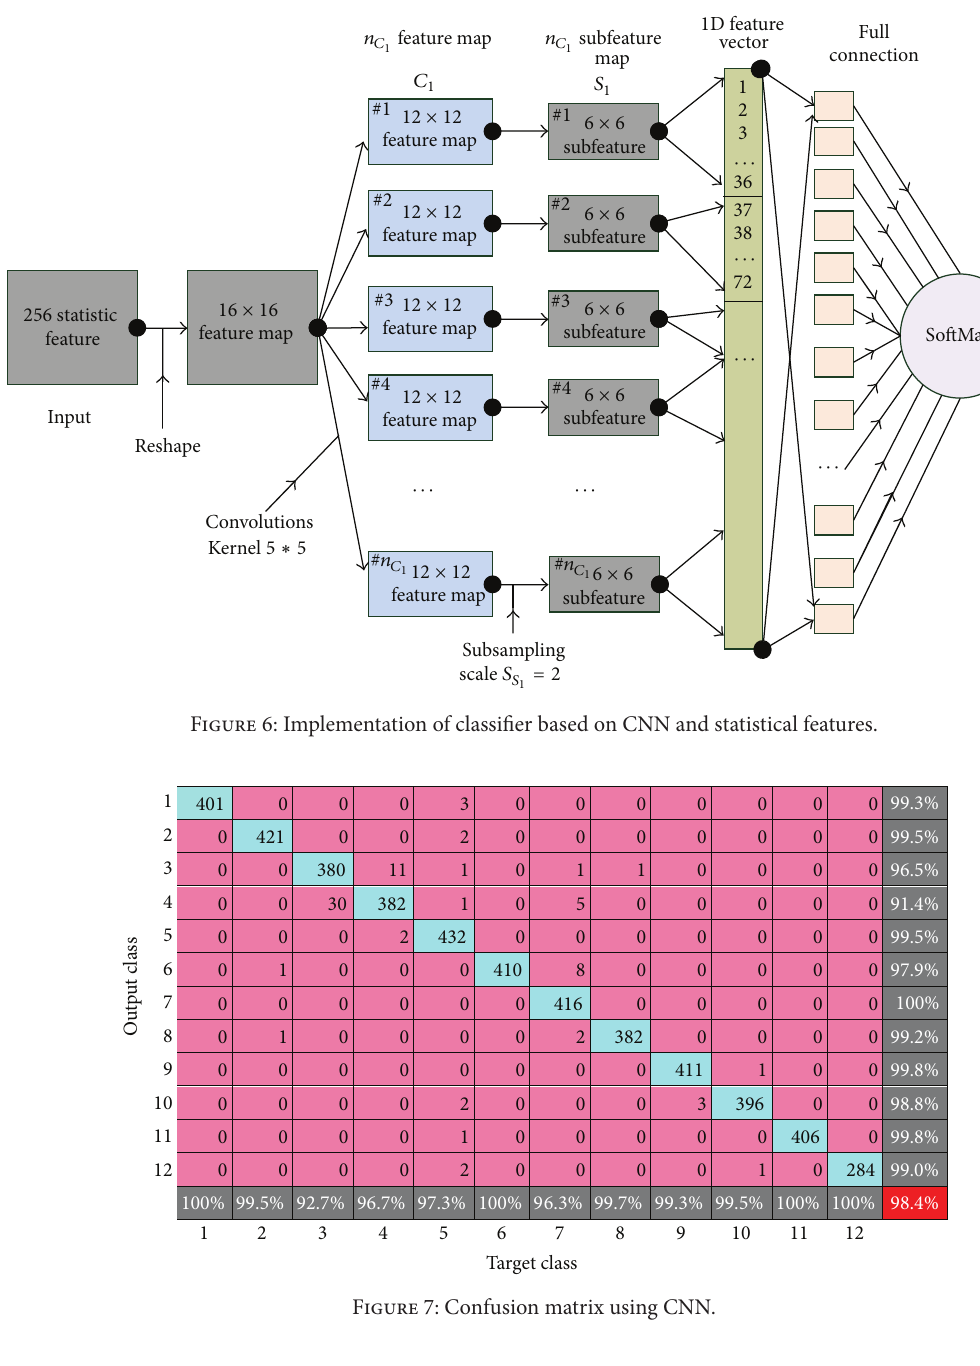
Table 7: Parameters tuning of